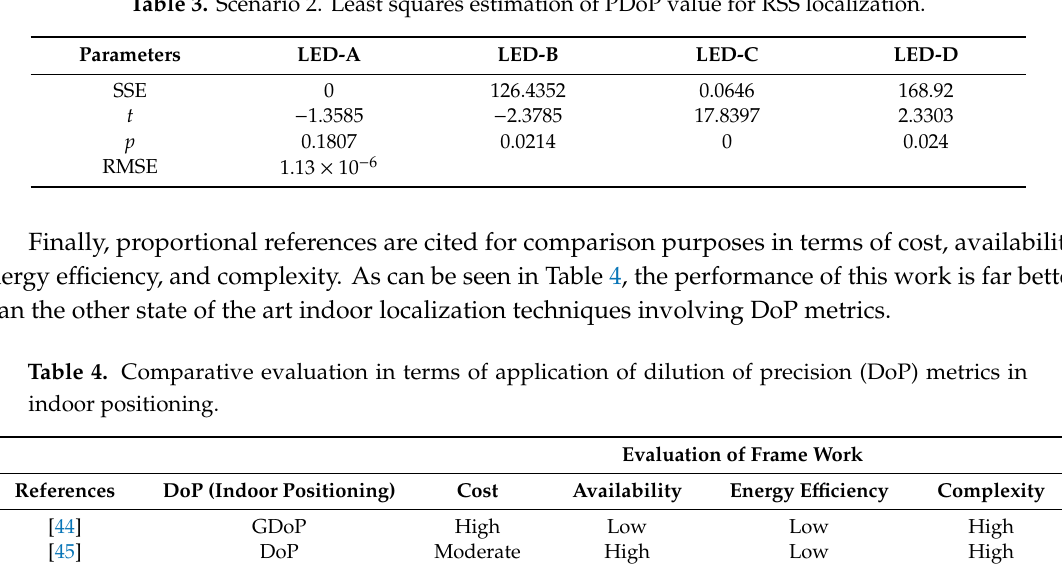
Table 3. Scenario 2. Least squares estimation of PDoP value for RSS localization.